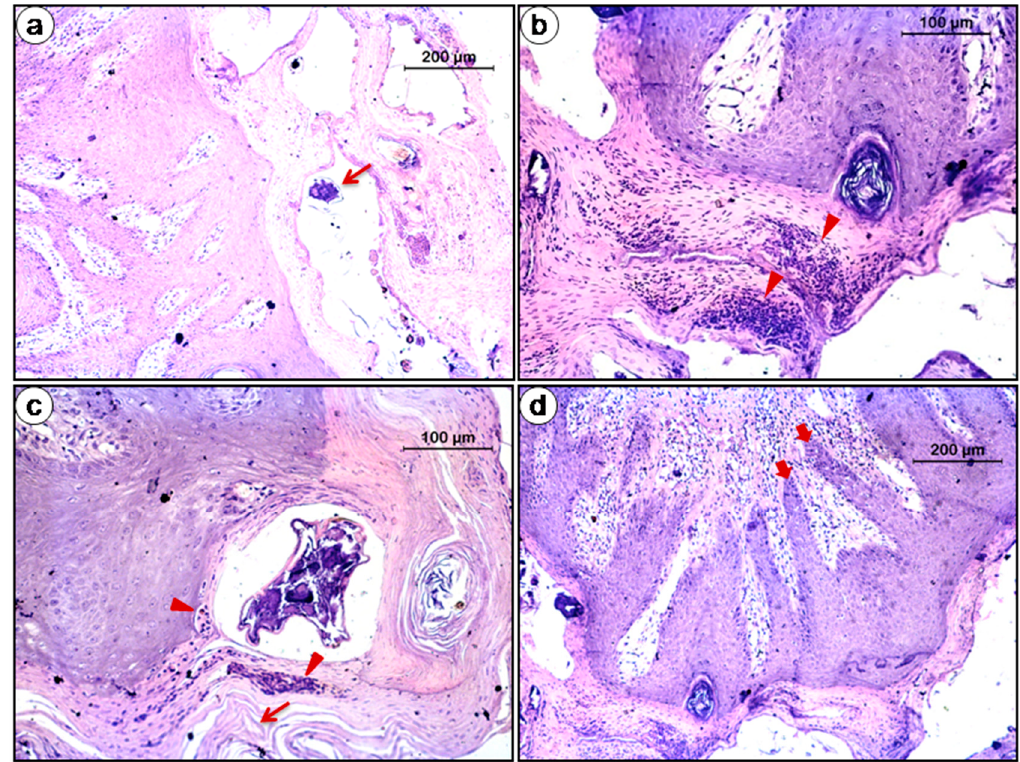
Figure 10. Histopathology of infested skin ( a ) Mite (arrow) with its exoskeleton and remnants prevailed in the tunnel of stratum cornium of epidermis (original magnification 100 × , scale bar: 200 µ m), ( b , c ) Parakeratotic hyperkeratosis characterized by upsurge in the thickness of the stratum corneum and excessive production of squames (arrow) followed by infiltration (arrow head) into epidermis suggested crust formation. There was infiltration of cells especially eosinophils (arrow head) into epidermis and dermal vascular area causing dermatitis (original magnification 200 × , scale bar: 100 µ m), ( d ) Psoriasiform hyperplasia: Note the epidermal projections (block arrow) into the dermis for interdigitaion with dermal papillae (original magnification 100 × , scale bar: 200 µ m).